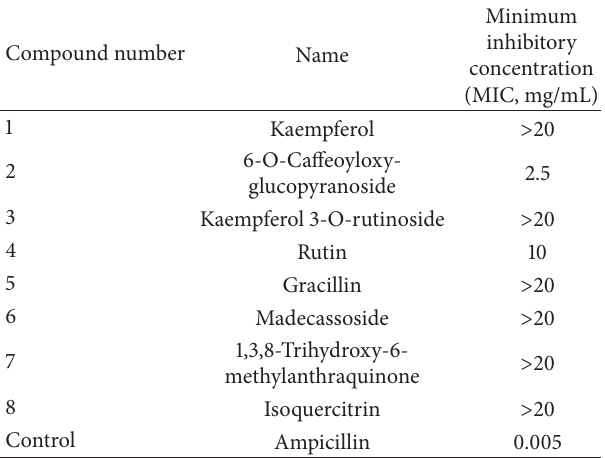
Table 3: Minimum inhibitory concentrations (MIC) of Sanjin Tablets compounds to E. coli